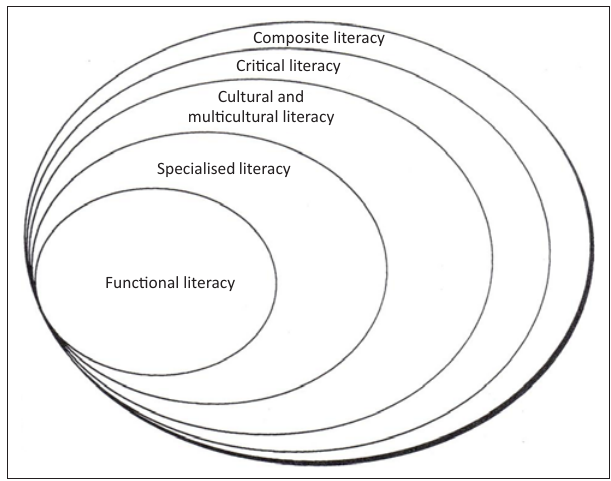
FIGURE 1: The spheres of literacy